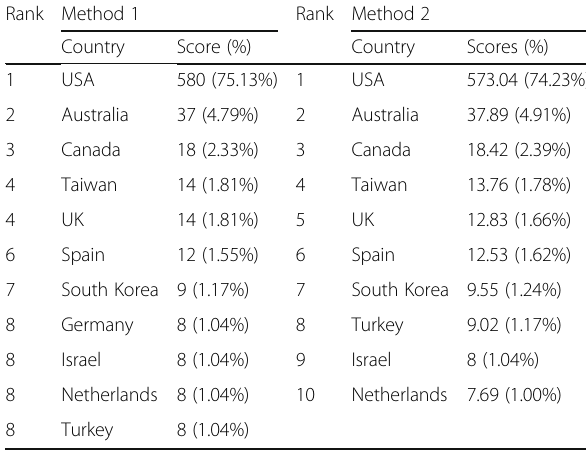
Table 4 Top 10 authorship countries/regions for 772